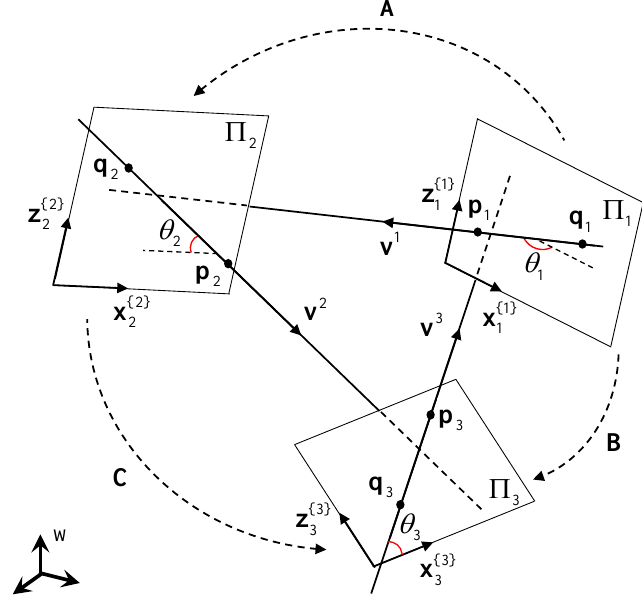
Figure 3. Three lines on three planes. From the three known angles among the lines, we drive three equations of θ 1 , θ 2 and θ 3 . A , B and C indicate the known rotation matrices from Π 1 - to Π 2 -coordinate system, from Π 1 - to Π 3 -coordinate system, and from Π 2 - to Π 3 -coordinate system,